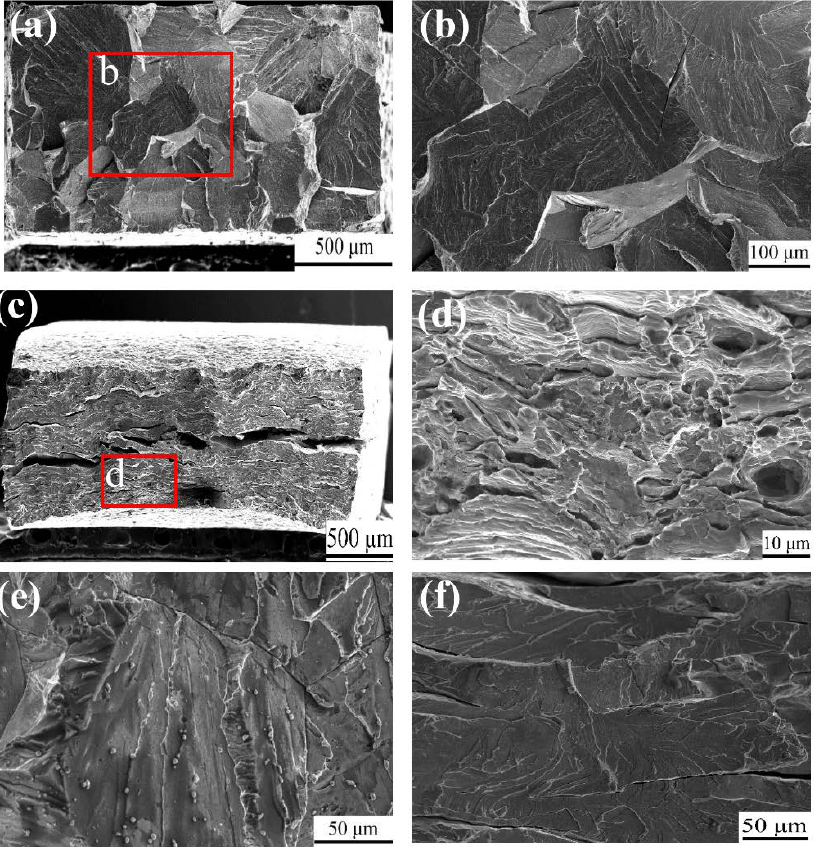
Figure 6. SEM fracture surface tensiled in air: ( a ) as‐cast; ( c ) hot‐rolled; ( b , d ) magnified of the parts of red rectangles; tensiled in a 3.5 wt % NaCl solution with 5 × 10 −7 s −1 : ( e ) as‐cast; ( f ) hot‐rolled.